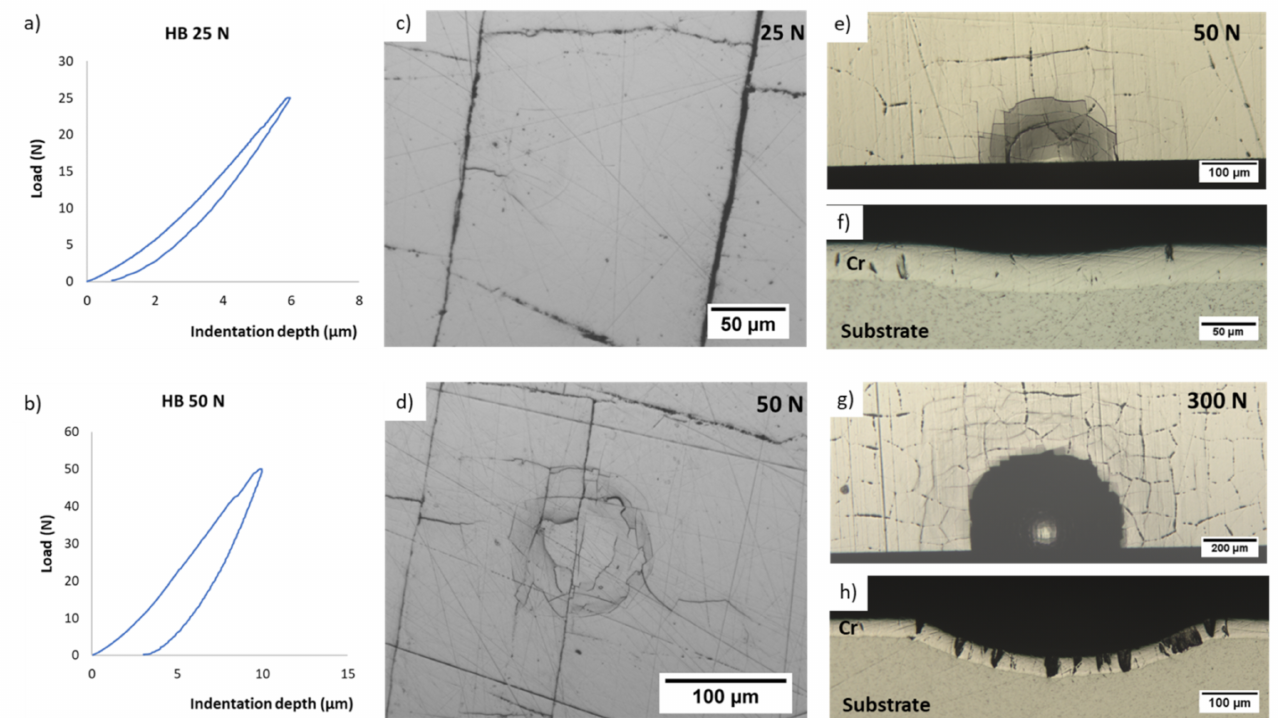
Figure 3. Instrumented hardness tests with a 1 mm ball: ( a , b ) loading–unloading curves, ( c , d ) postmortem optical observations of indentations (thickness of 100 µ m). Instrumented hardness tests with a 5 mm ball: postmortem observations of indentations by optical microscopy ( e , g ) on the surface and ( f , h ) in section (thickness of 40 µ m).